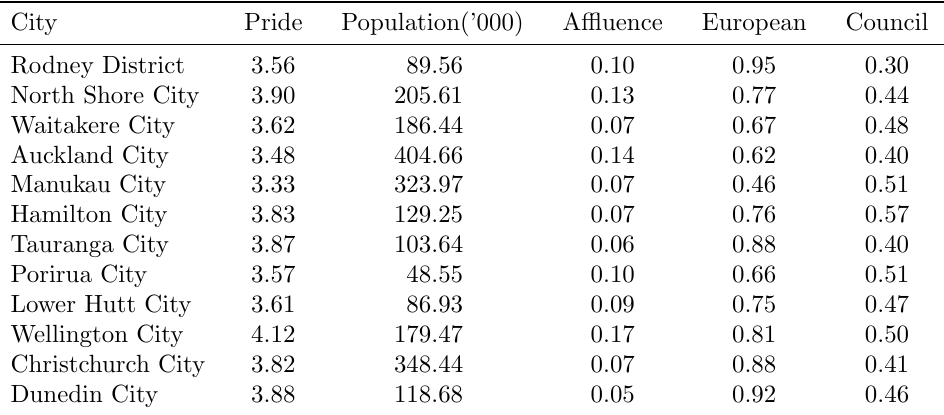
Table 6: Selected characteristics of the twelve New Zealand